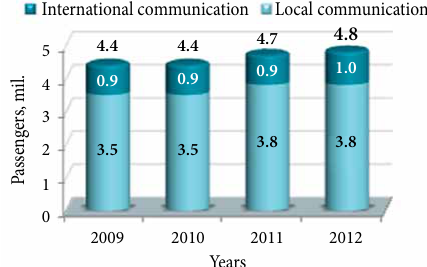
Fig. 1. The dynamics of passenger flows in 2009–2012 (mil)